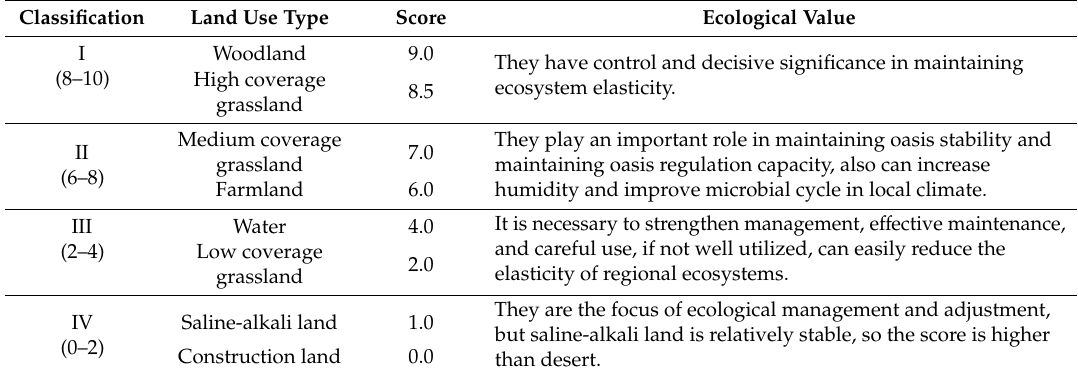
Table A3. Eco-resilience score of di ff erent land use types.